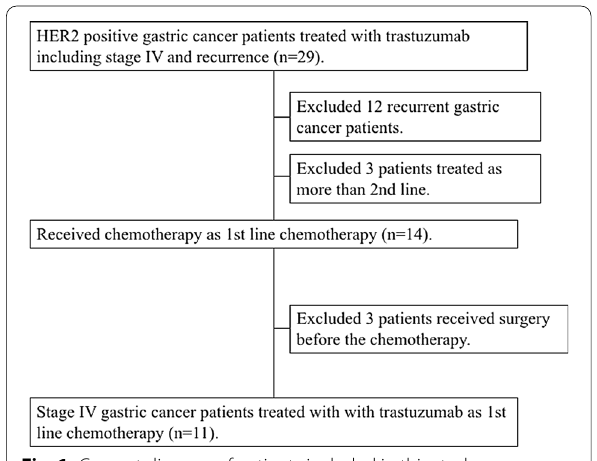
Fig. 1 Consort diagram of patients included in this